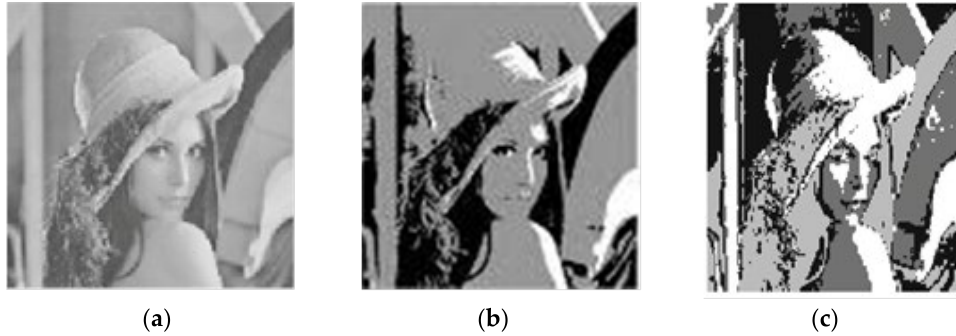
Figure 1. Lena segmented the image by ( a ) original image, ( b ) PIABC-FCM, and ( c ) IABC-FCM.